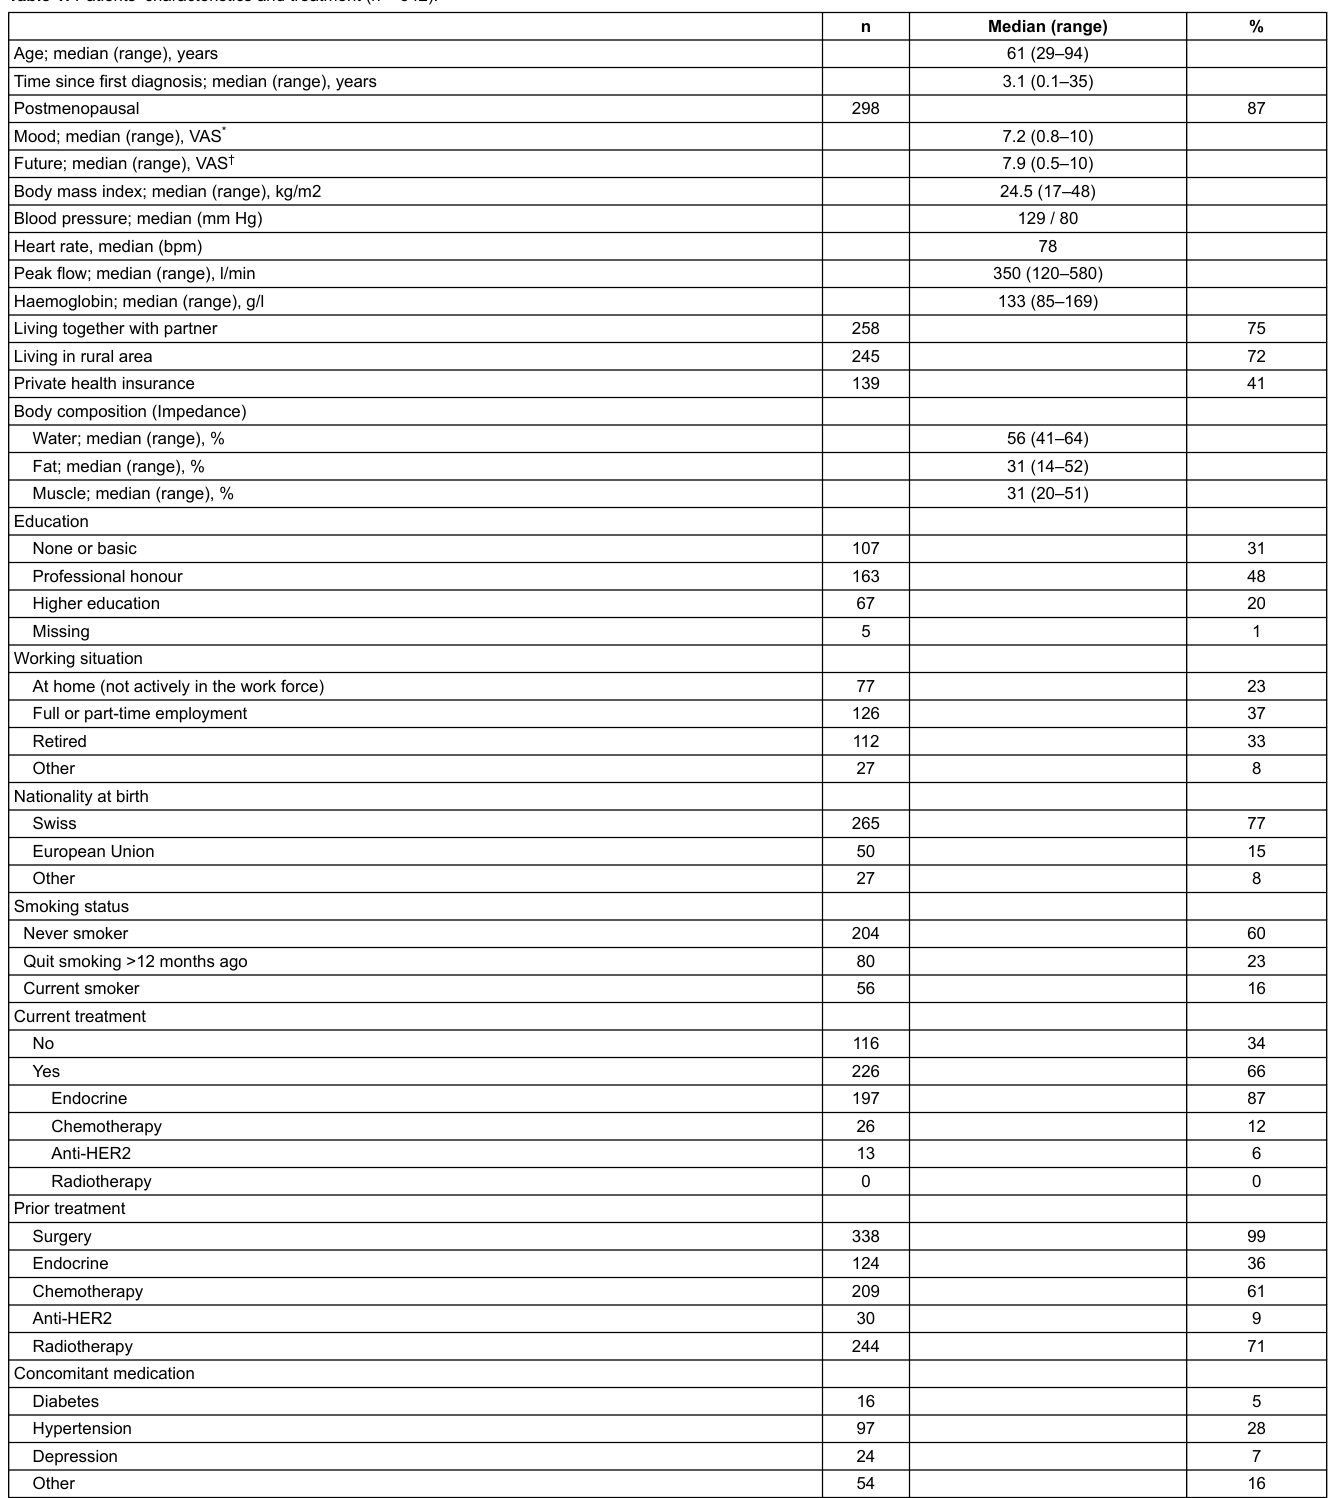
Table 1: Patients’ characteristics and treatment (n =